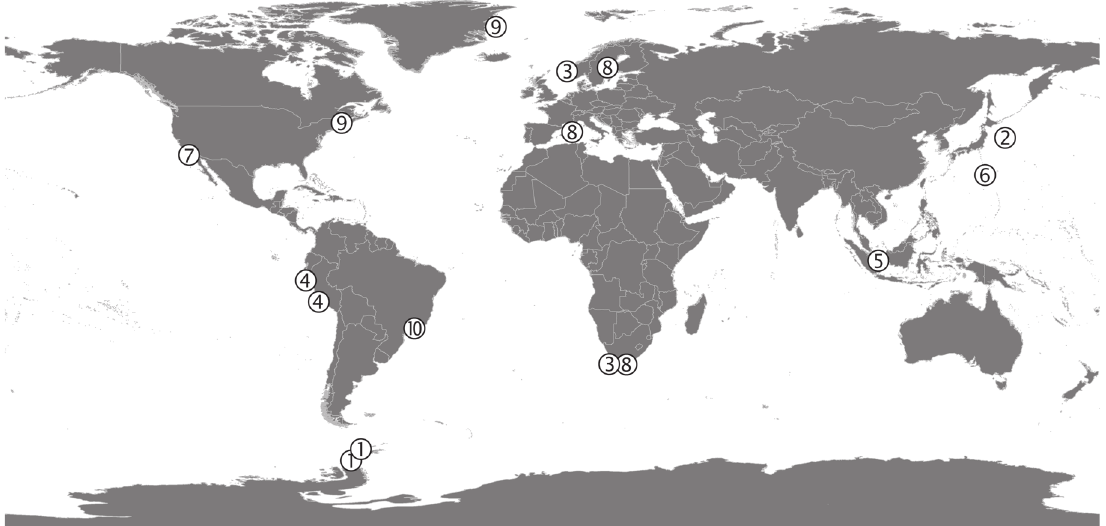
Figure 10. Known distribution of species of Lumbriclymene : (1) L. australis ; (2) L. campanulata ; (3) L. cylindricauda ; (4) L. fusca ; (5)